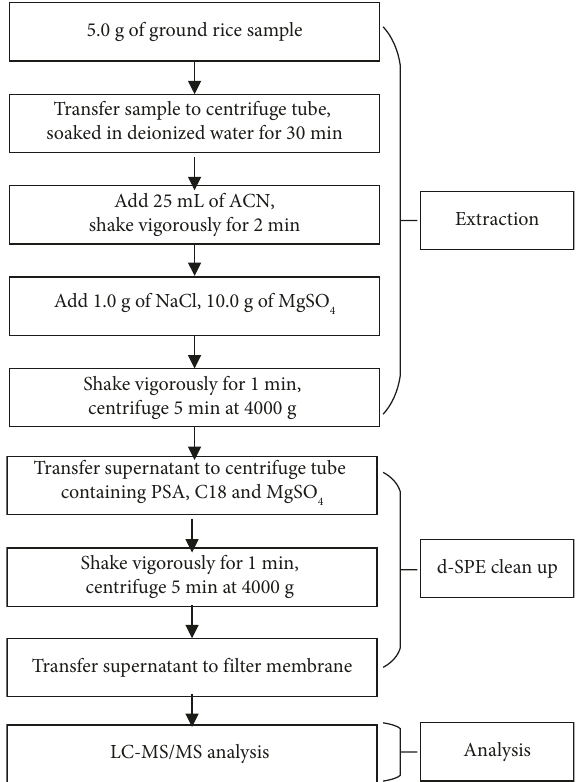
Figure 2: The flowchart of the analytical procedure of pesticide residues in rice